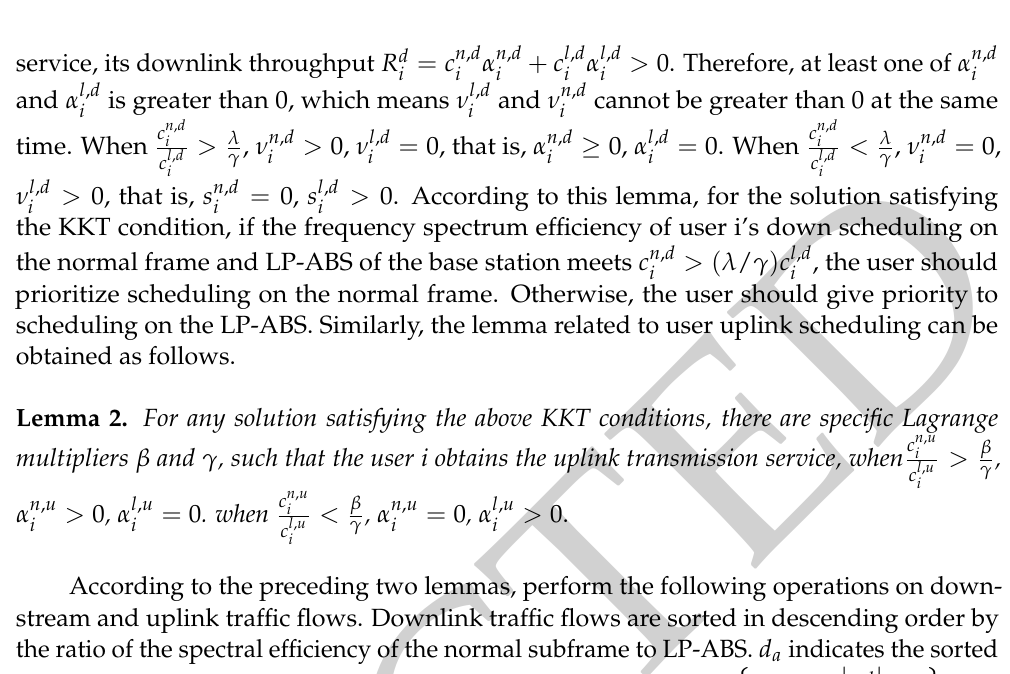
Figure 4. The traffic flows in Γ d